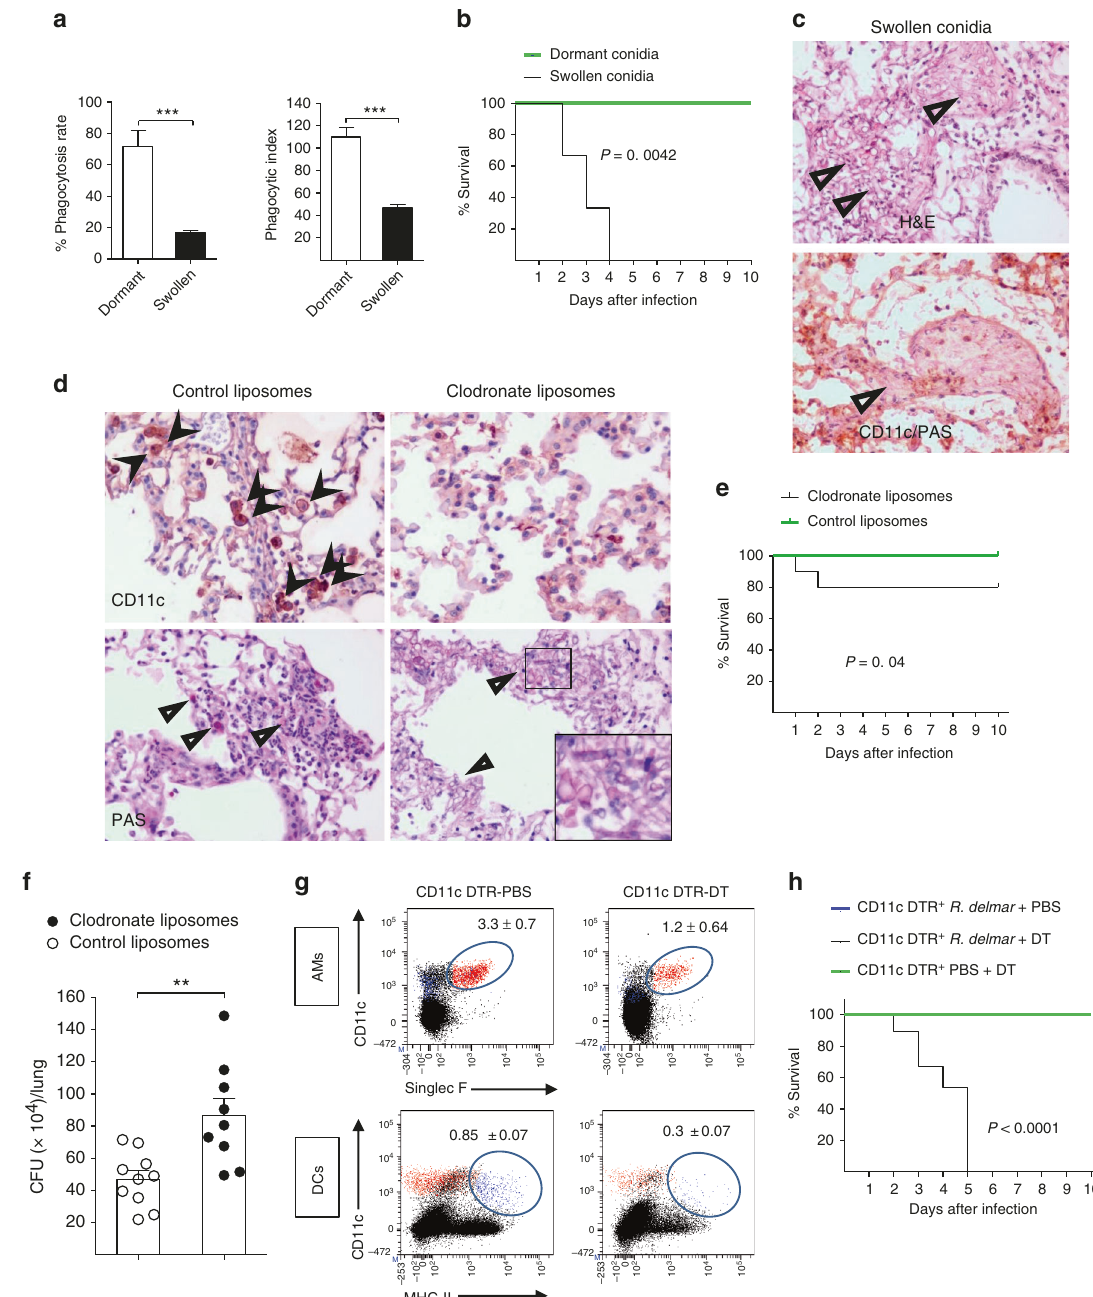
Fig. 6 AMs have a non-redundant role in immunity against Rhizopus . a GFP-LC3 BMDMs were infected with dormant or swollen conidia of R. oryzae at